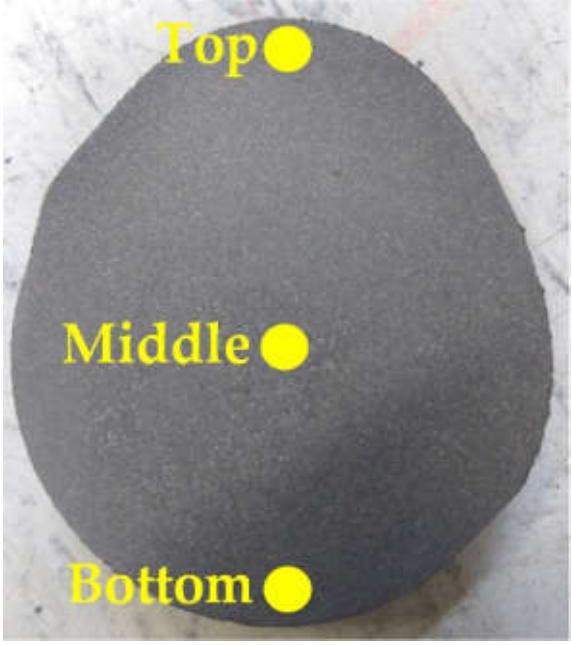
Figure 1. Lobe taken from camshaft showing the three regions analyzed.